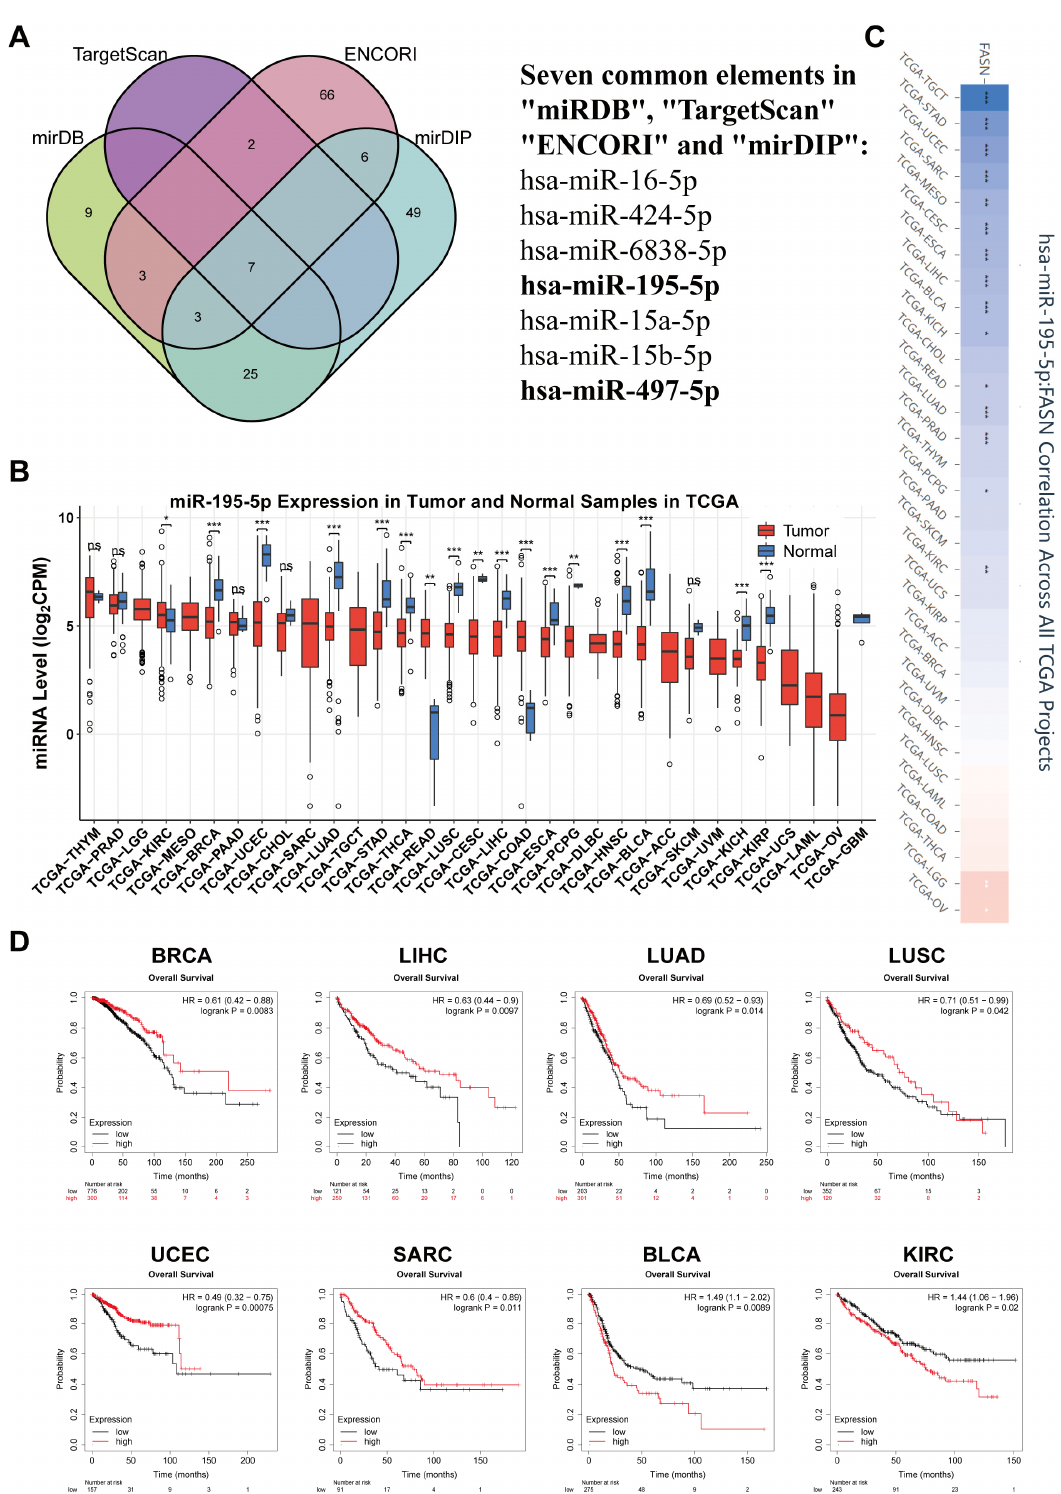
Figure 9. Mir-195-5p is a potential regulatory gene of FASN. ( A ) mirDB, TargetScan, ENCORI, and mirDIP four databases were used to analyze miRNAs that may target FASN, and obtain seven conserved miRNAs by overlap. Expression profile of mir-195-5p in different cancers ( B ) and correlation with FASN ( C ) analyzed with CancerMIRNome. (* p < 0.05, ** p < 0.01, *** p < 0.001, ns: p > 0.05.). ( D ) Kaplan–Meier plotter analysis of the correlation between the expression of mir-195-5p and prognosis in multiple cancers. The survival map and Kaplan–Meier curves with positive results are